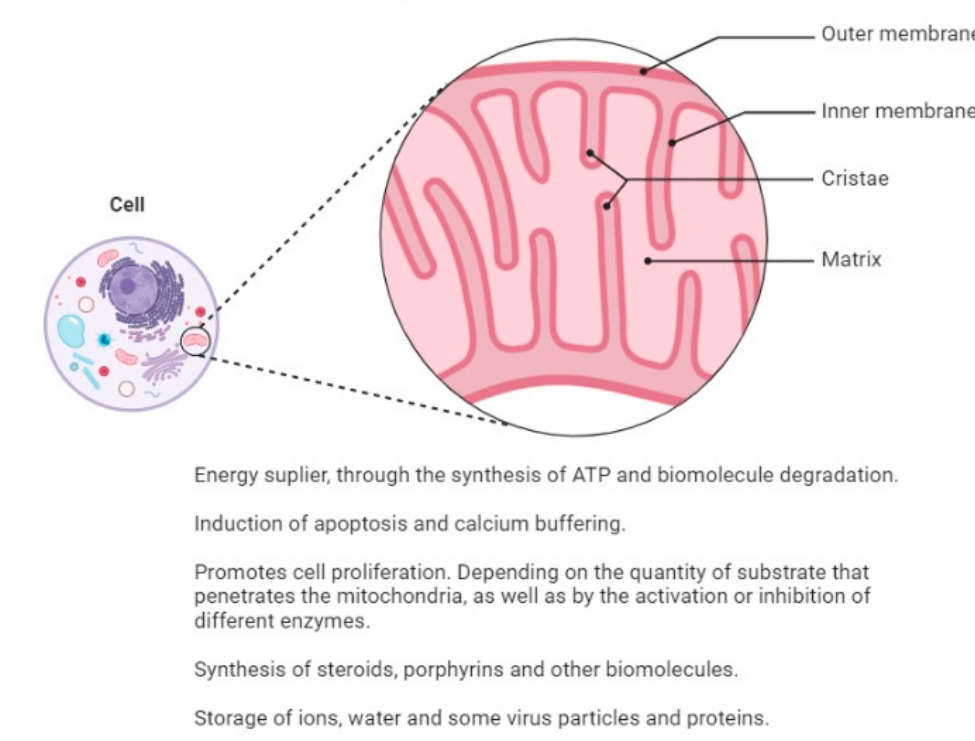
Figure 1. Mitochondria structure and functions.